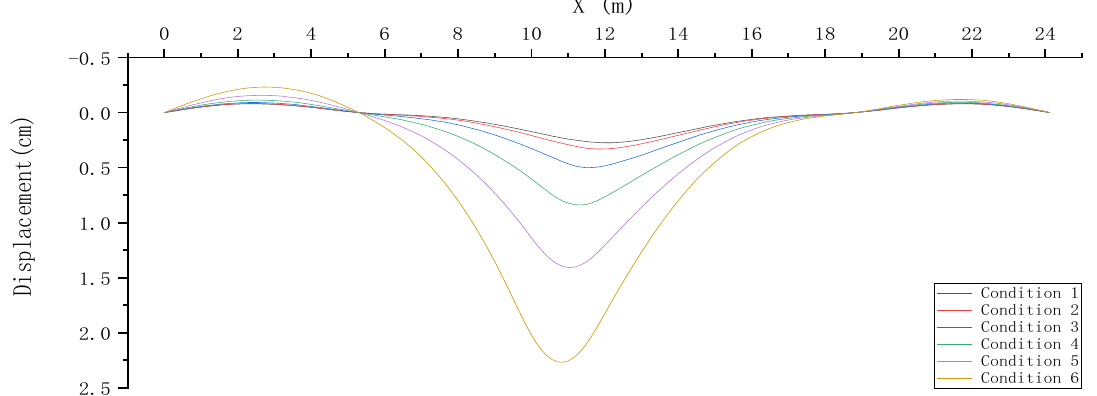
Figure 18. The global holographic deformation under different damage conditions.